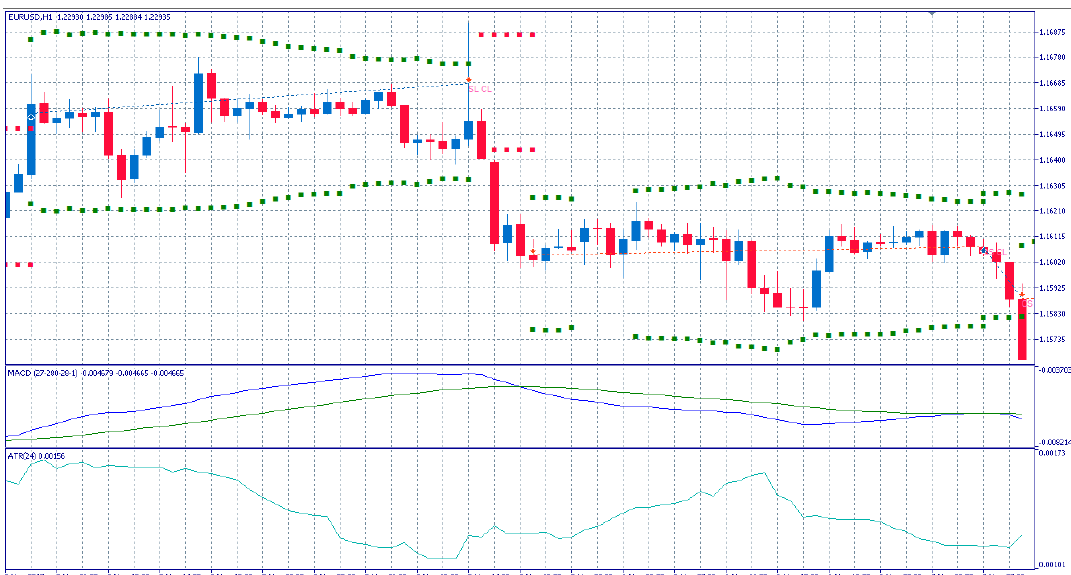
Figure 5. A segment from an MACD Expert Advisor’s trading on EURUSD. The green dots show how the ATR window changes in width as the ATR value changes over time.